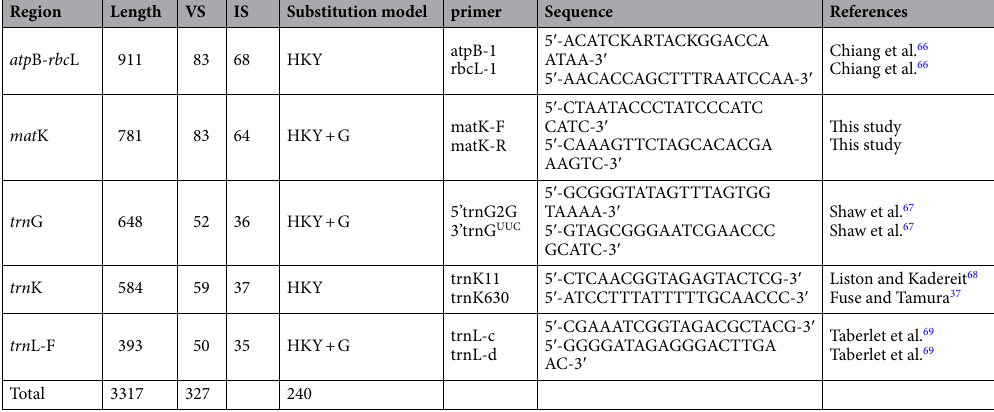
Table 1. Information of cpDNA dataset and primer used in the phylogenetic analysis. Length aligned length of each loci, VS variable sites, IS informative